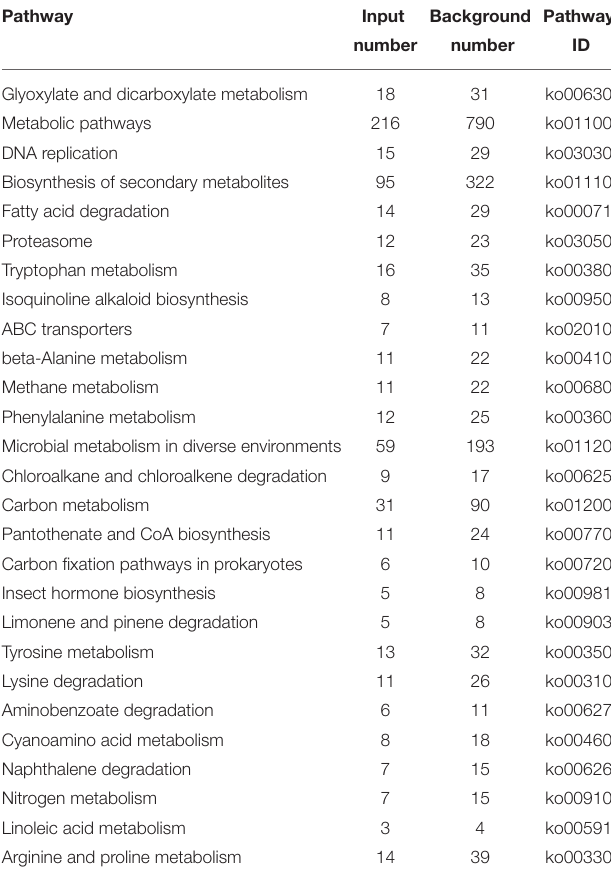
TABLE 3 | Mostly enriched KEGG pathway of DEGs in P. digitatum